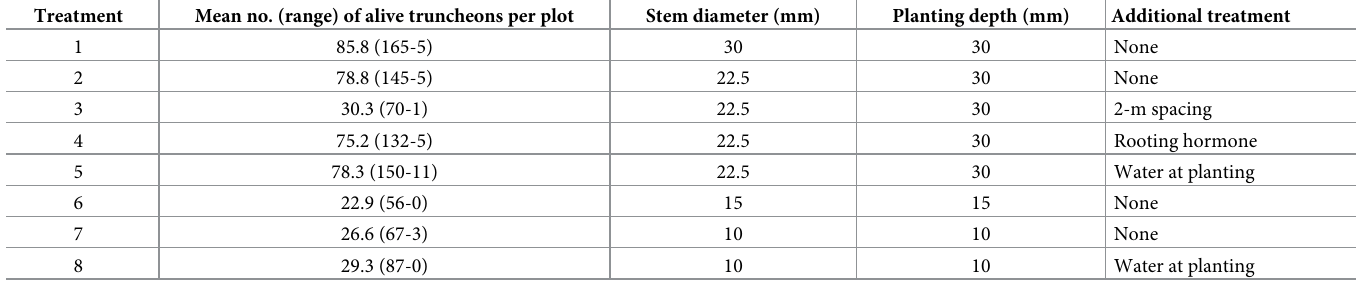
Table 1. Treatments applied to truncheons of spekboom ( Portulacaria afra ) planted in 40 plots (0.25 ha) located across the extent of spekboom thicket vegetation (see Fig 2). Treatment Mean no. (range) of alive truncheons per plot